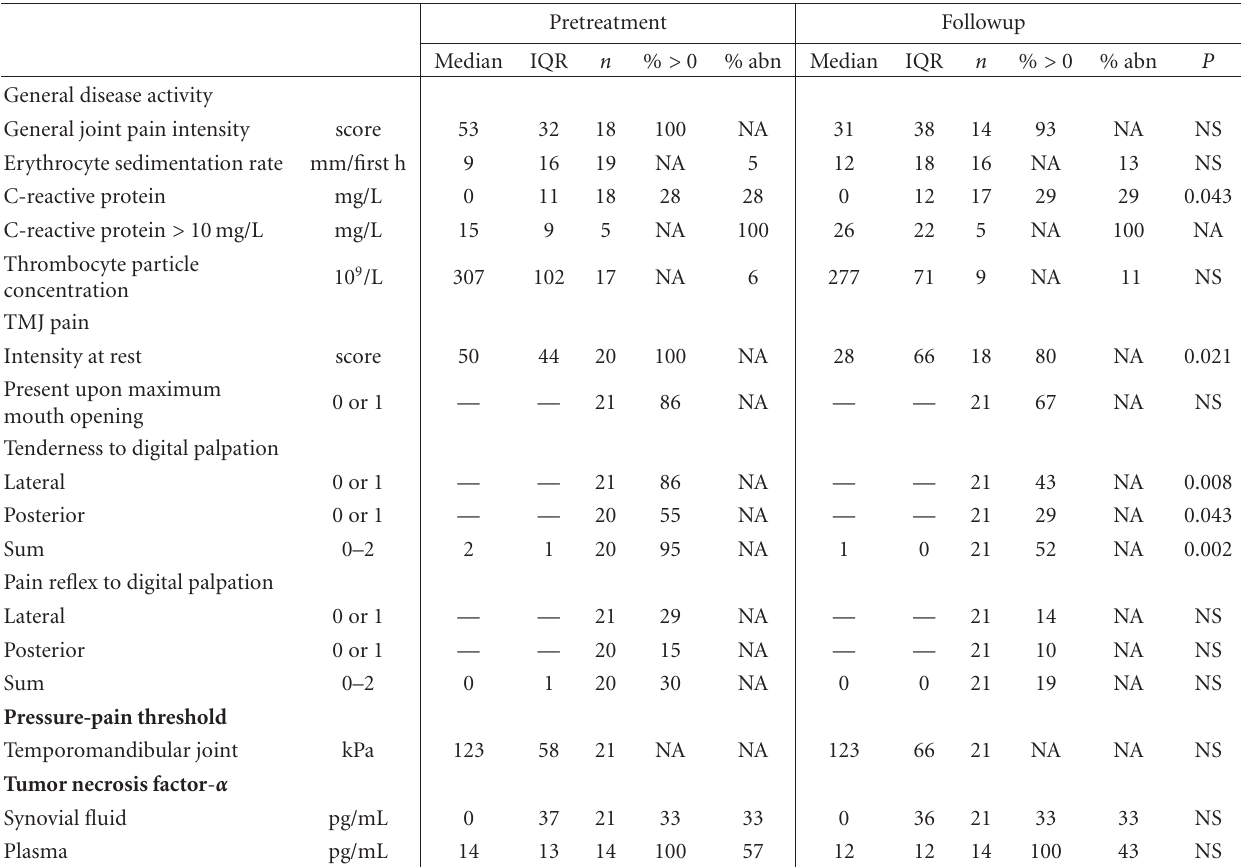
Table 2: General and temporomandibular joint (TMJ) variables before and after intra-articular administration of glucocorticoid (median interval 40 days) in 21 female patients with chronic inflammatory TMJ disorders. The TMJ data refer to the most painful joint if bilateral injections were